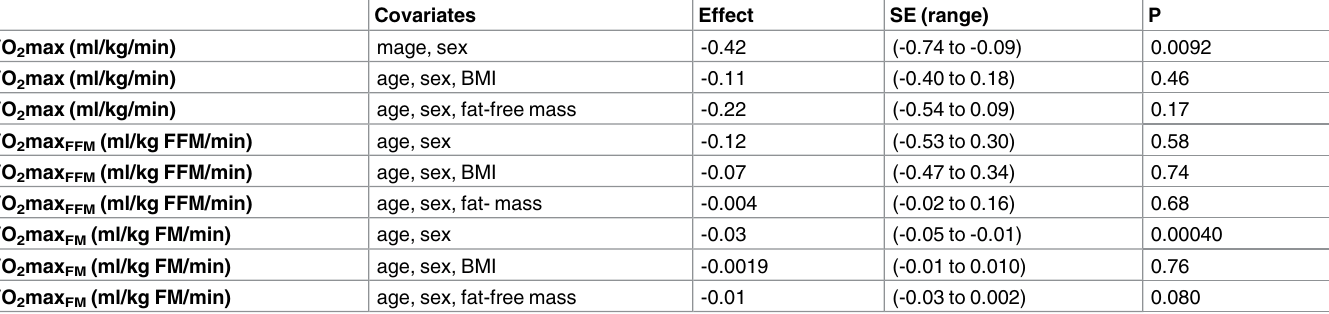
Table 3. Associations between the FTO rs1558902 A-allele and VO 2 max (ml/kg/min), VO 2 max FM (ml/kg FFM/min) as well as VO 2 max FFM (ml/kg FM/ min) after meta-analysis of two Danish cohorts (ADDITION-PRO (n = 716) and Health2006 (n = 2586)), assuming a fixed effect